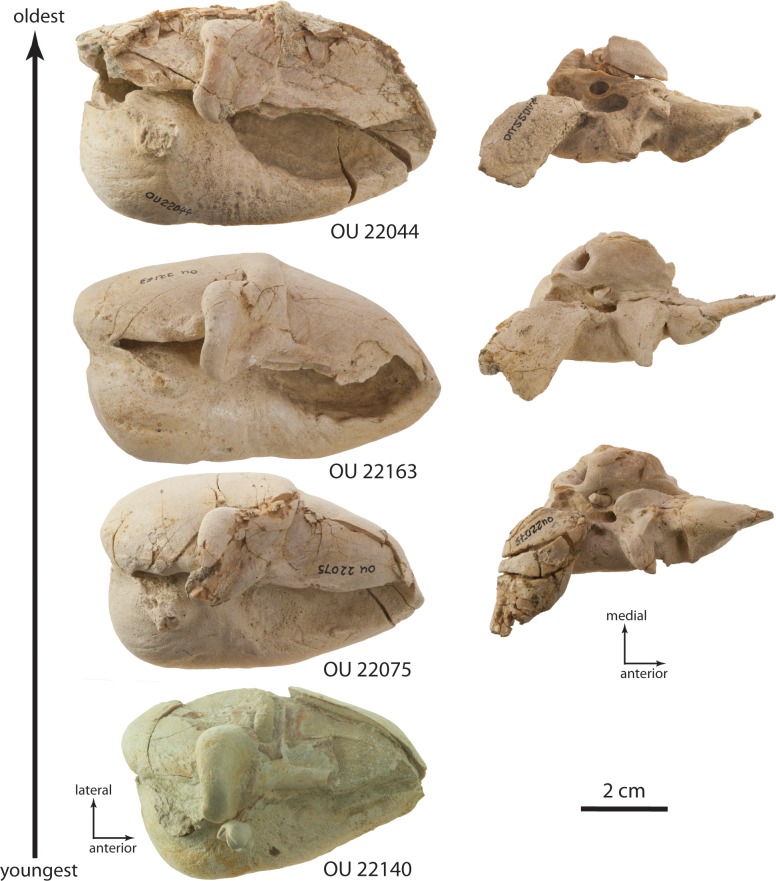
Tympanoperiotic ontogeny of Waharoa ruwhenua.